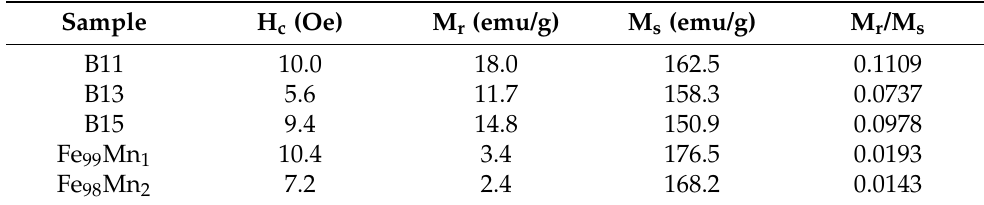
Table 3. Relevant parameters extracted from the magnetic hysteresis loops of samples B11, B13, B15, Fe 99 Mn 1 , and Fe 98 Mn 2